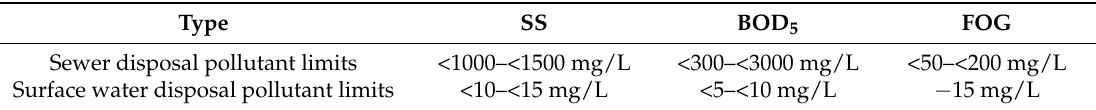
Table 2. Minimum requirements for wastewater disposal to sewer and surface water in most of the Australian states